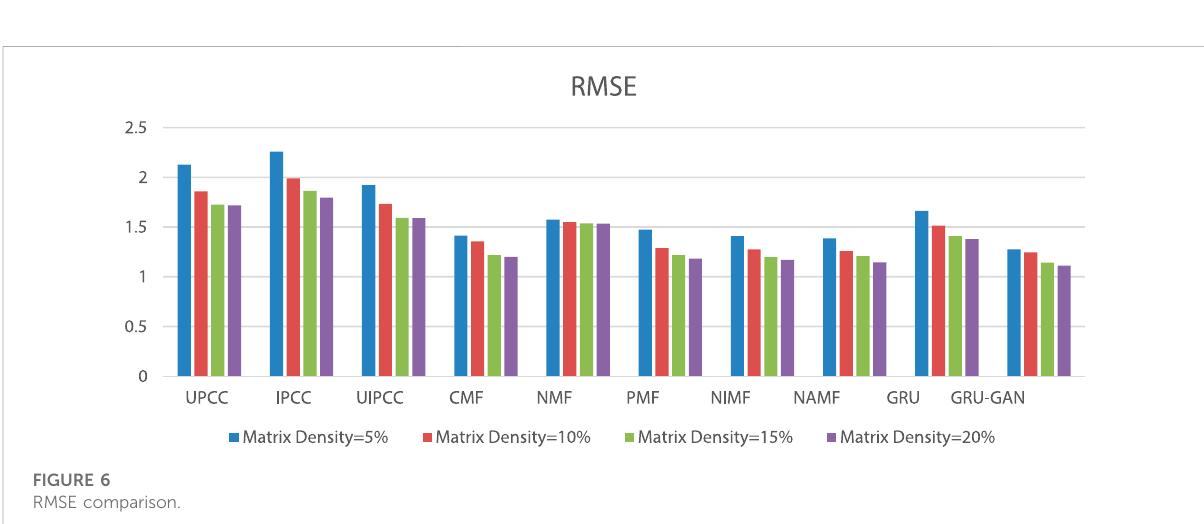
FIGURE 5 MAE comparison.